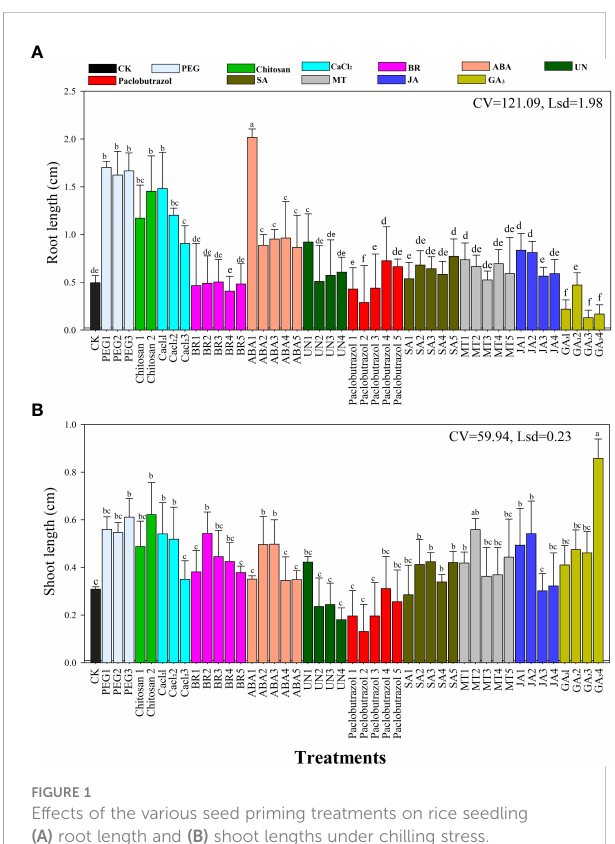
FIGURE 1 Effects of the various seed priming treatments on rice seedling (A) root length and (B) shoot lengths under chilling stress. CV — coef fi cient of variation; Lsd — least signi fi cant difference. Different lowercase letters indicate signi fi cant differences (P< 0.05). See Table 1 for treatment details. Bars indicate standard